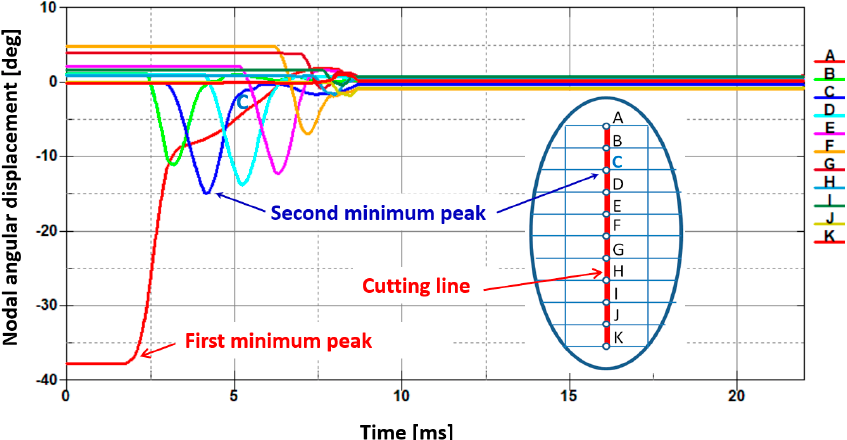
Figure 10. Juxtaposition of changes of an angular displacement in the function of time for each node situated on the cutting line and denoted by letters from A to K for the top sheet in a bundle with respect to the model presented in Figure 2.